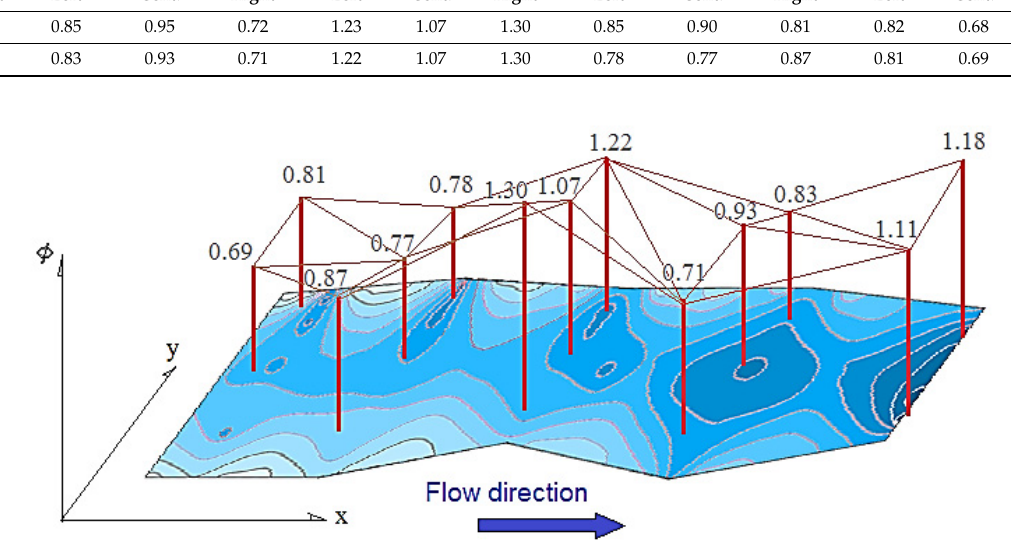
Figure 8. 3D illustration of the measured ϕ in the investigated reach.